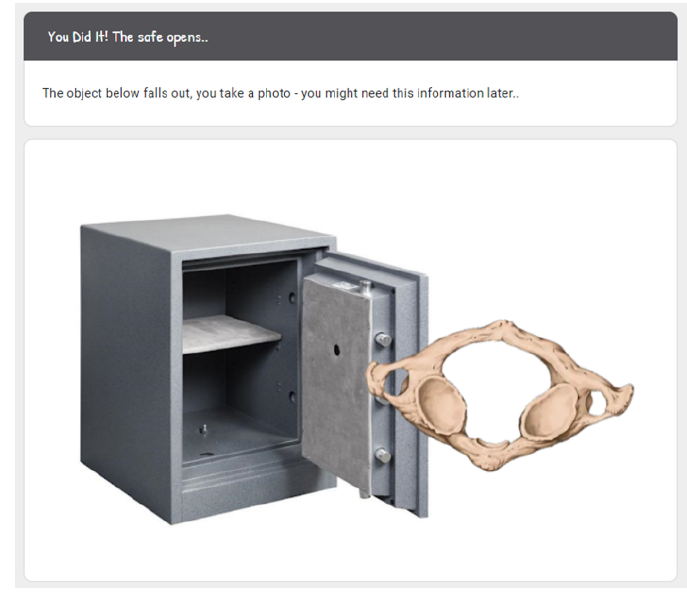
Figure 5. Example Clue from the Anatomy Escape Room